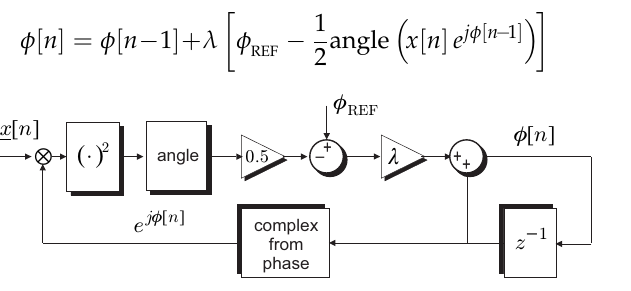
Figure A7. Block diagram of automatic phase control